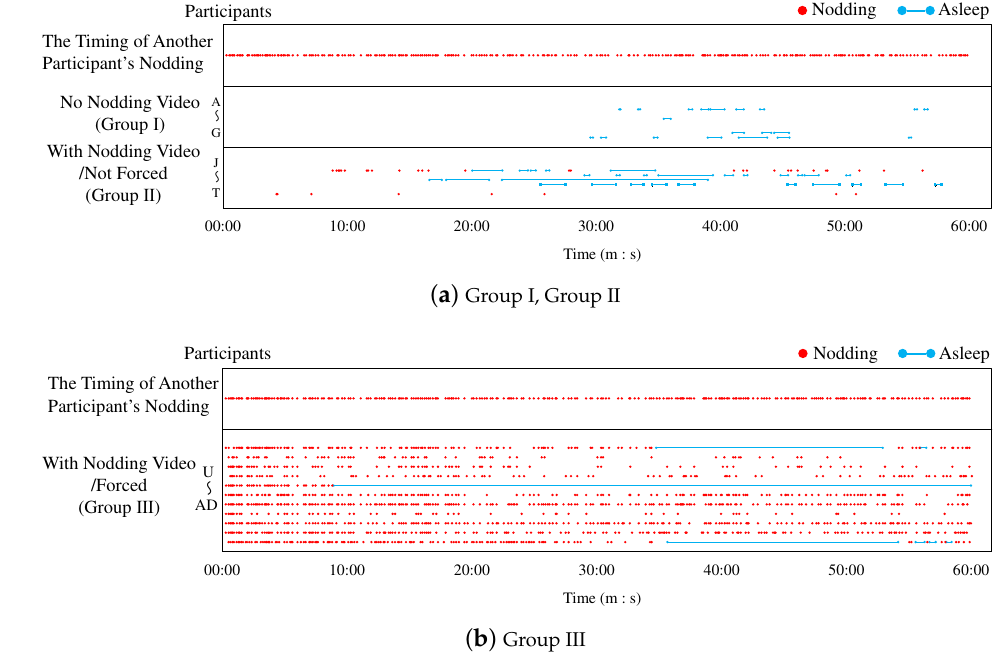
Figure 6. Time series data of nodding in the second half of the